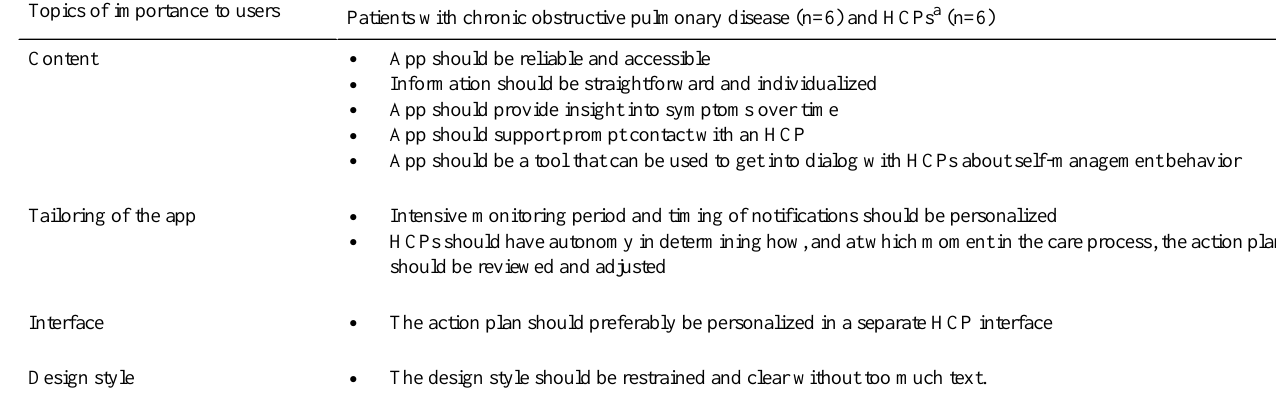
Table 1. Usability requirements for the mobile health